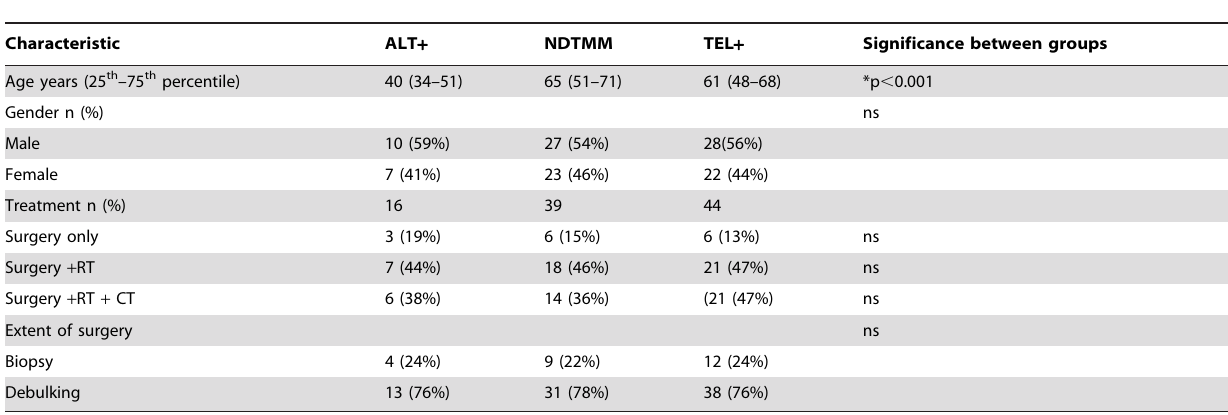
Table 1. Demographic Characteristics of GBM Patients.